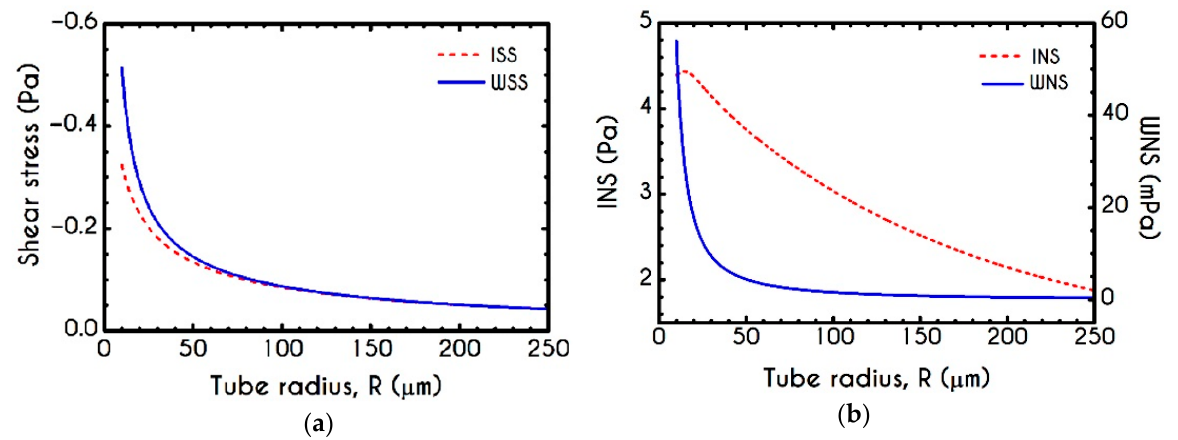
Figure 12. ( a ) Interfacial (ISS) and Wall (WSS) Shear Stresses and ( b ) Interfacial (INS ) and Wall (WNS) Normal Stresses as a function of the tube radius R for U mean = 1 mm/s and H c = 0.45. Table 5. Coefficients of Equation (23) for ISS, WSS, INS, and WNS for U mean = 1 mm/s and H c = 0.45. Parameters Units Values for